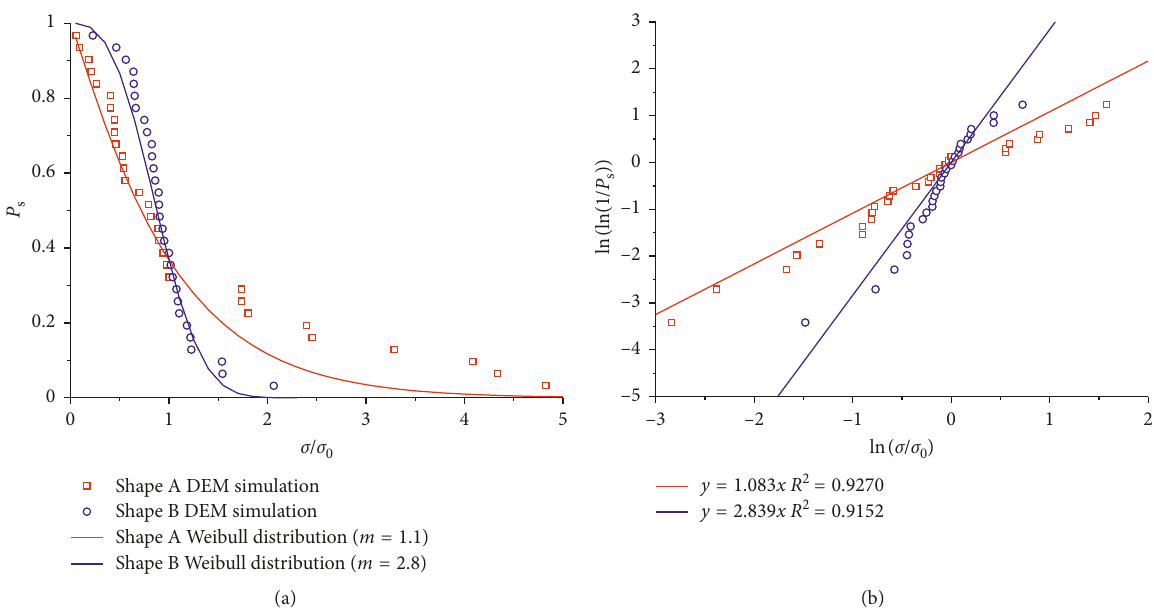
Figure 7: Weibull distribution function for the agglomerates of the two shapes: (a) normalized distribution; (b) Weibull